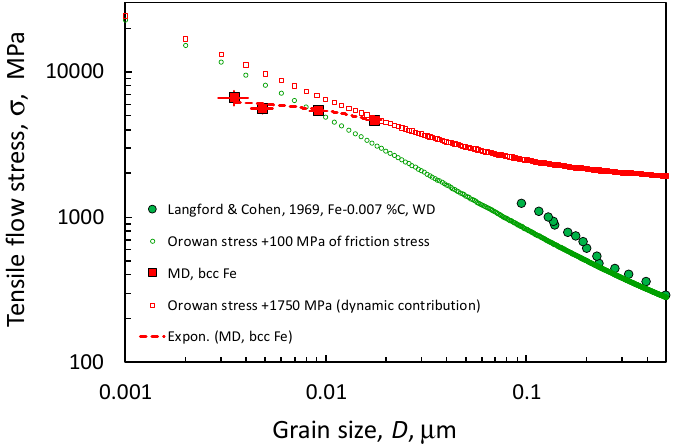
Figure 12. Experimental VME flow stress vs. grain size in the cross-section of <110> textured axisymmetrically drawn iron wires (Fe-0.007%C, from Langford and Cohen [58]) and MD results (molecular dynamics simulations) of similar (but finer) structures of pure iron from ref. [22]. Superposed: the critical stress for bowing a dislocation to the curvature of the grains (the Orowan equation) plus a 100 MPa additive term representing the friction stress from the lattice (appropriate for Fe-0.007%C) or a 1.75 GPa dynamic friction stress (appropriate for the MD simulations because of the very high strain rate employed in the calculations, 10 8 m − 1 [22]).